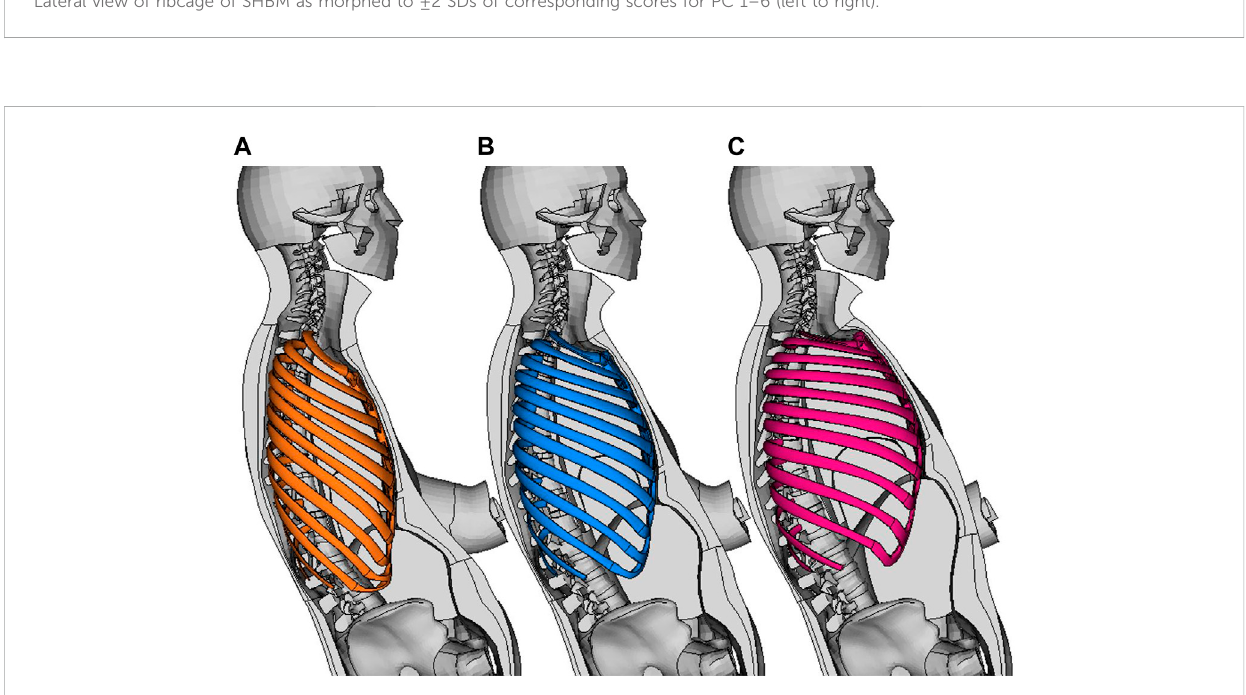
SHBMtorsowithpartsremovedtoshowribcageandinternalparts. (A) :Ribcagemorphedto − 2SDsofPC1score, (B) :0(averageribcageshape), (C) : +2 SDs for PC 1 (left to